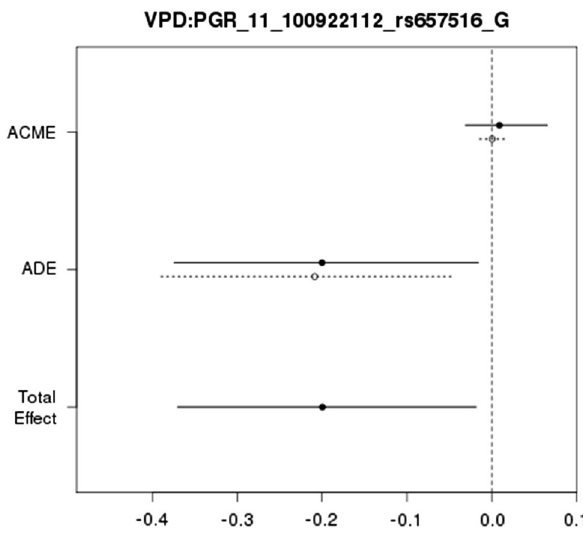
Fig. 4 Direct effect (ADE), mediation effect (ACME) and total effect by geno- type (solid line: